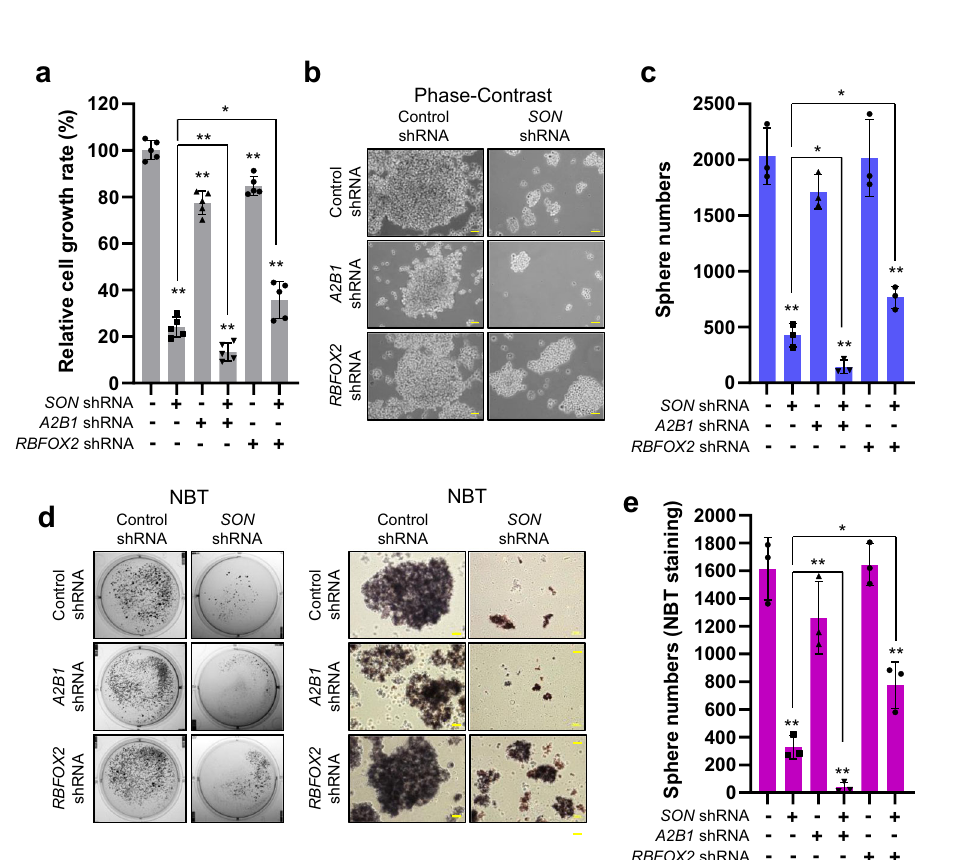
Fig. 7 SON depletion leads to suppression of proliferation, sphere formation, and clonogenic ability of GSCs, and these effects are facilitated by hnRNP A2B1 knockdown but abrogated by RBFOX2 knockdown. a Cell growth rate was determined by MTT assay of GSC #83 expressing indicated shRNAs ( n = 5). b , c Representative phase-contrast images of the GSC spheres ( b ) and a graph indicating sphere numbers ( c , n = 3) formed by the GSCs with the knockdown of the indicated genes. Images are representative of n = 3 independent experiments. Yellow bars, 50 µ m. d Alkaline phosphatase assays were conducted by nitro blue tetrazolium chloride (NBT) staining with GSCs to assess the effect of knockdown of the indicated genes in GSC sphere formation. Representative images of NBT-stained spheres ( n = 3) viewed as a whole plate (left) and the magni fi ed images (right). Yellow bars, 50 µ m. e The histogram indicates the number of NBT-positive spheres ( n = 3). Error bars in all graphs represent the standard deviation (SD) of tests. NS not signi fi cant, * p < 0.05, ** p < 0.01. Statistical signi fi cance was determined by an unpaired two-tailed t -test. Source data are provided in the Source data fi Since PTBP1 and PTBP2 regulate a large number of cassette exons during neuronal differentiation, inhibition of PTBP1 and concurrent upregulation of PTBP2 is required for initiation of neural differentiation 17 – 19 . PTBP2 upregulation has largely been thought as a result of reduction of its suppressor PTBP1, and few upstream regulators for PTBP1 and PTBP2 have been reported ognized RNA splicing cascade that controls a large number of (e.g., miR-124 for PTBP1 45 , RBFOX2 for PTBP2 53 ). However,